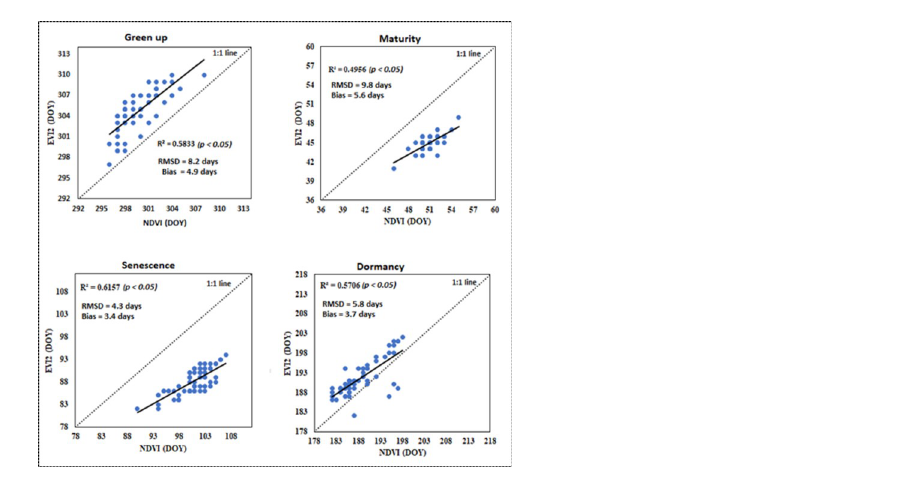
Fig 4. Statistical comparison between NDVI and EVI2 derived bracken fern phenological dates.